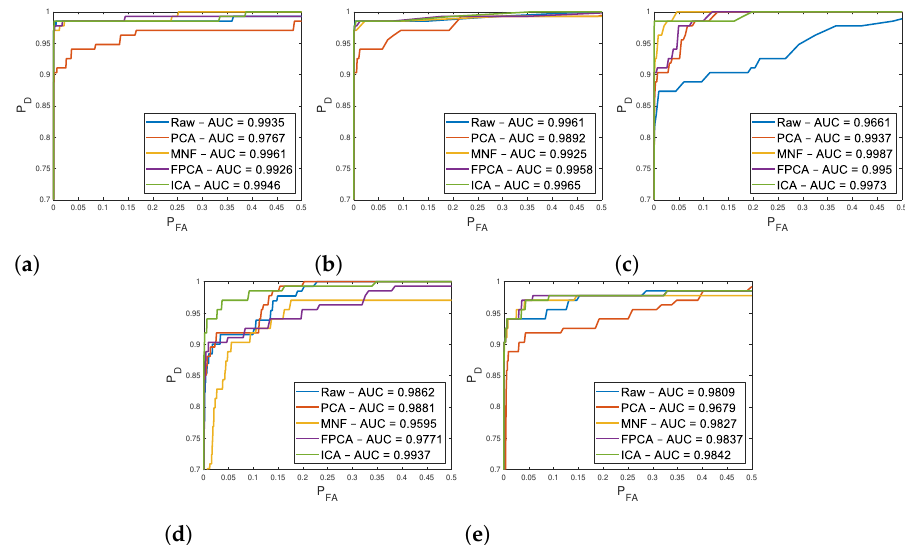
Figure 5. ROC Curves for each TD and spectral DR scheme pairing on the full scene. ( a ) ACE. ( b ) CEM. ( c ) SAM. ( d ) SID. ( e )